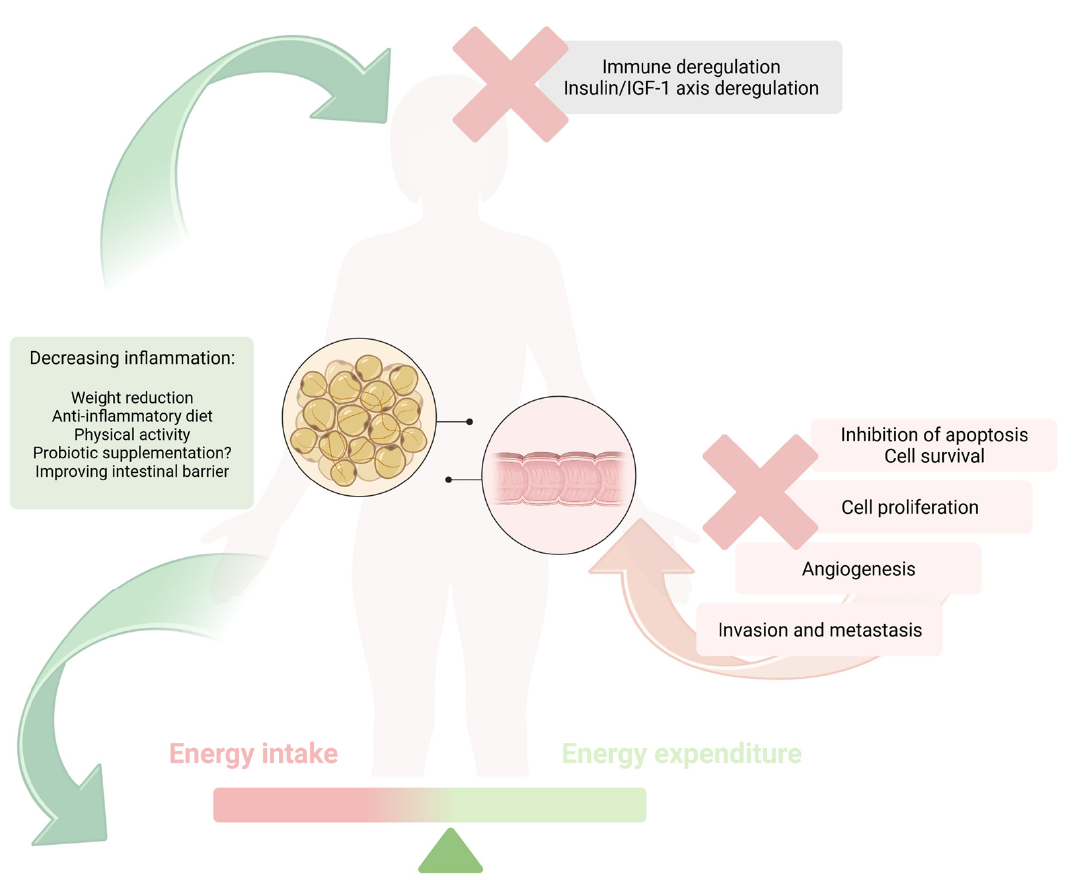
Figure 2. Summarized approaches focused on obesity-related factors increasing the risk of CRC.